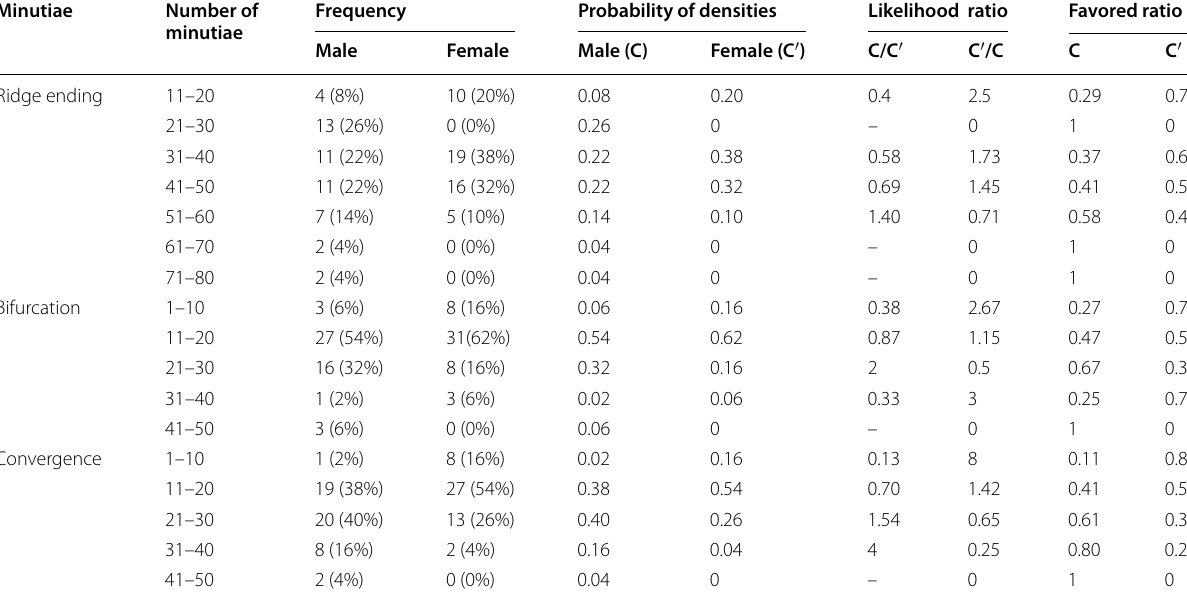
Table 6 Probability of proportions, likelihood ratio, and favored odds of male and female in right hand Minutiae Number of Frequency Probability of densities Likelihood ratio Favored minutiae